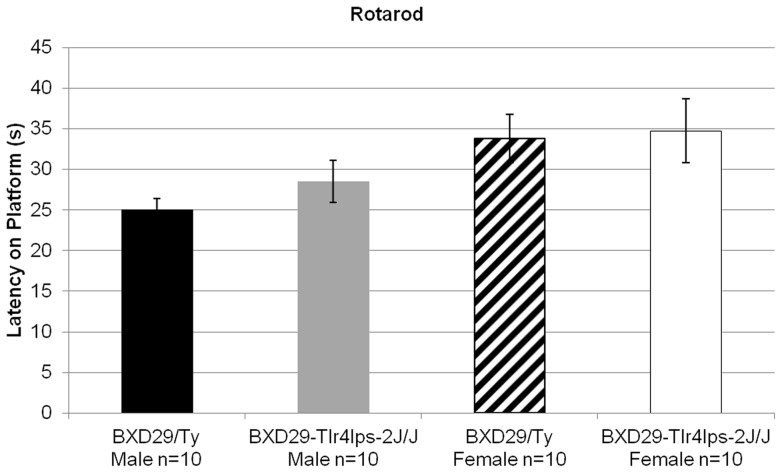
Rotarod performance of BXD29-Tlr4lps−2J/J mutant and BXD29/Ty wildtype mice.No main effect of Strain or Sex × Strain interaction was observed on the rotarod task, demonstrating the lack of sex differences in the BXD29-Tlr4lps−2J/J strain of mice.